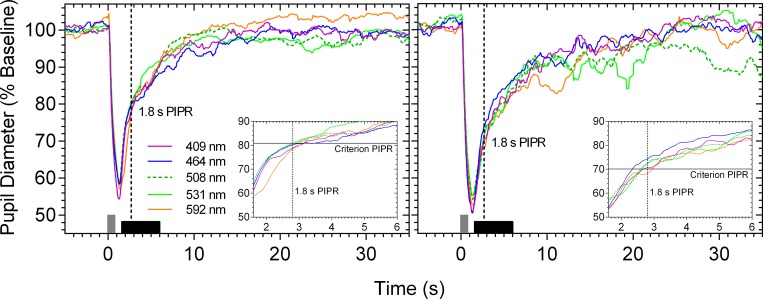
Exemplar pupil light reflex traces of participant 32/F (left panel) and participant 31/M (right panel) in response to five test wavelengths to produce a criterion PIPR amplitude (% of baseline pupil diameter) at 1.8 s after light offset. The vertical grey bar at 0 s indicates the 1 s stimulus pulse. The horizontal black bar along the abscissa indicates the post-stimulus period (0.6 to 5.0 s) where the PIPR spectral sensitivity was measured. The insets show a magnified view of the traces (0.6 to 5.0 s post-stimulus). The vertical dashed lines in all panels indicate the 1.8 s PIPR time and the horizontal solid lines in the insets indicate the criterion PIPR amplitude.